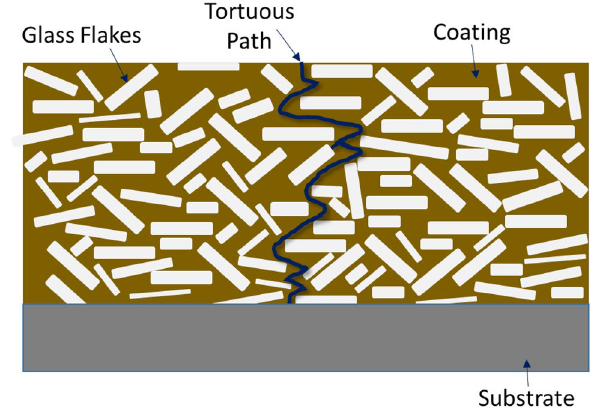
Fig. 4 Appearance of GFs in a coated